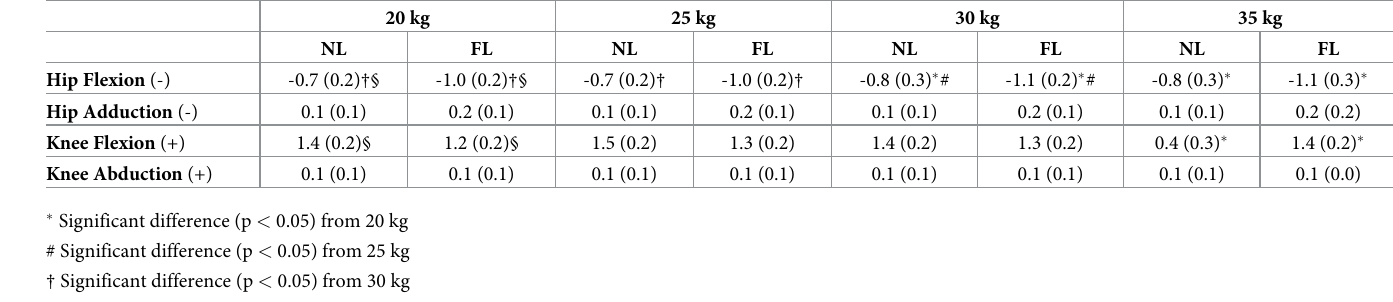
Table 4. Mean (SD) peak joint moments (N � m/kg � m) during normal (NL) and flexed (FL) drop